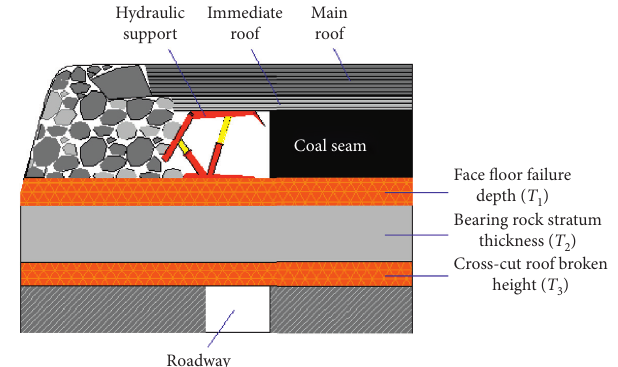
Figure 2: The components of rock strata.